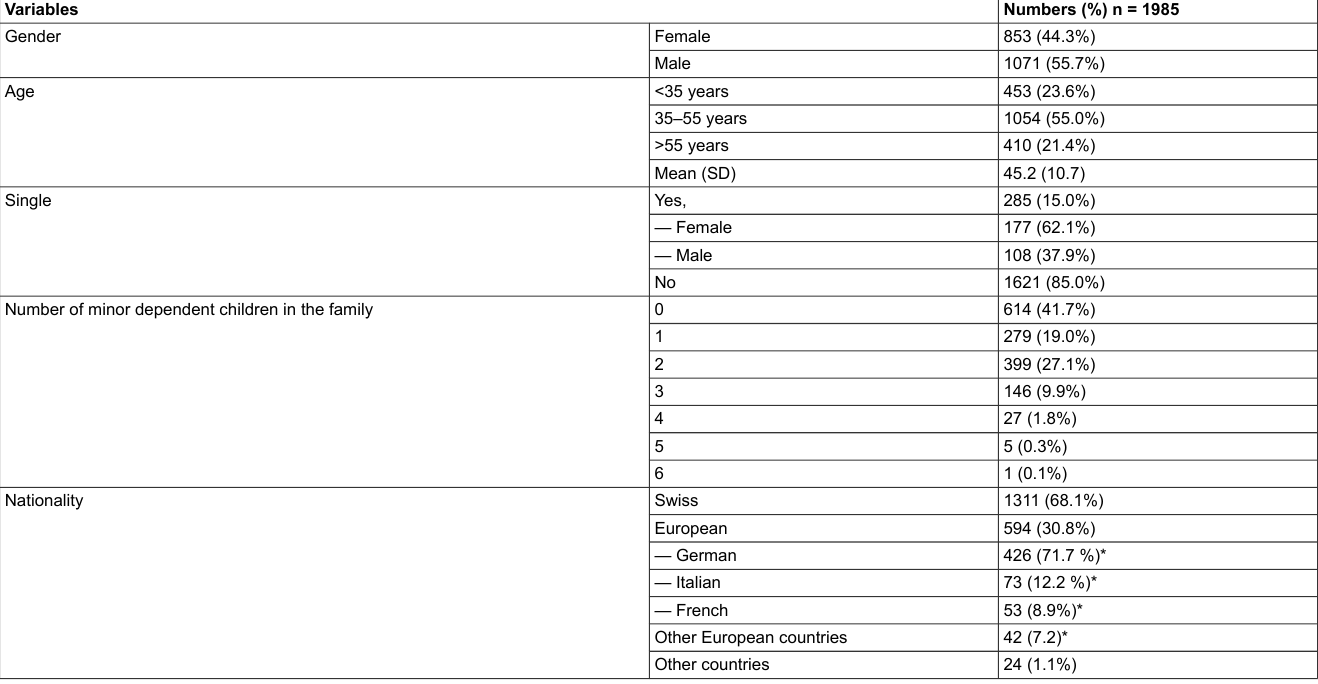
Table 2: Demographic characteristics of